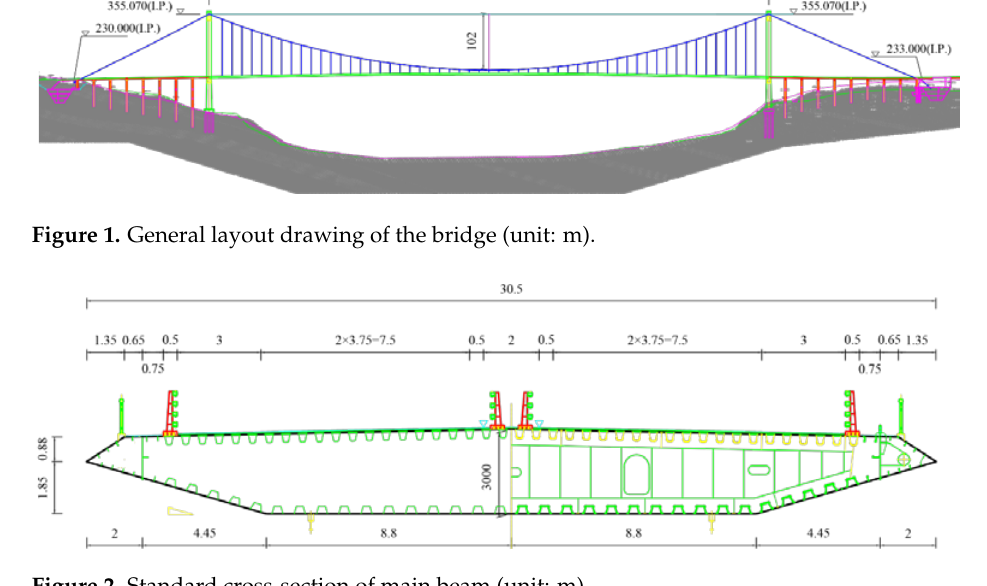
Figure 2. Standard cross-section of main beam (unit: m).